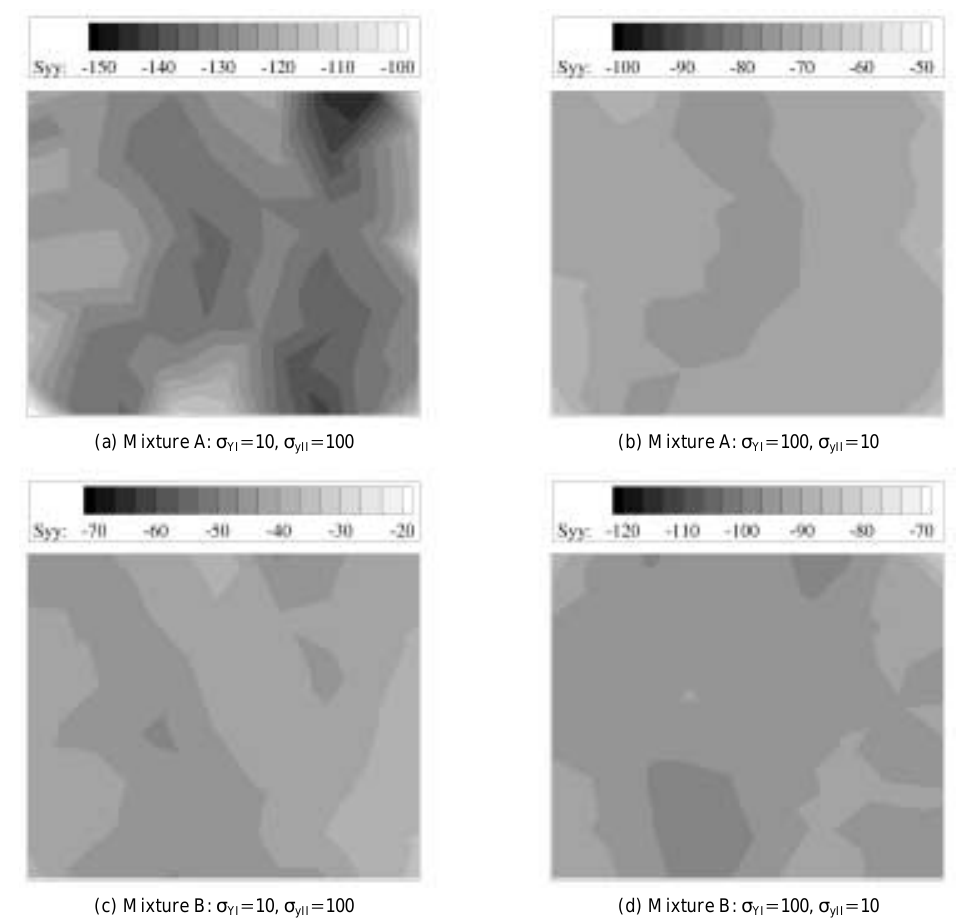
∆ /H stresses.(a) Mixture A Fig. 8 The global pressure-deformation responses of both mixtures at a various of combinations of yield